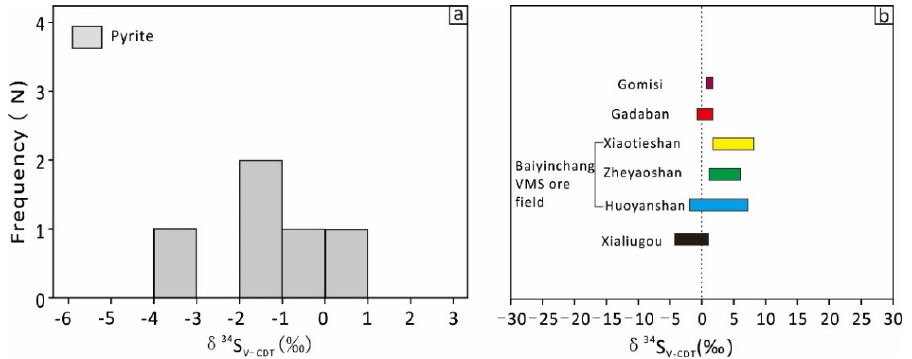
Figure 9. Histogram ( a ) and distribution ( b ) of δ 34 S V-CDT values for sulfide minerals from the Xialiugou deposit. Dates for Huoyanshan, Zheyaoshan, and Xiaotieshan deposit cited from [51,55]; dates for Gadaban and Gomisi deposit cited from [45].